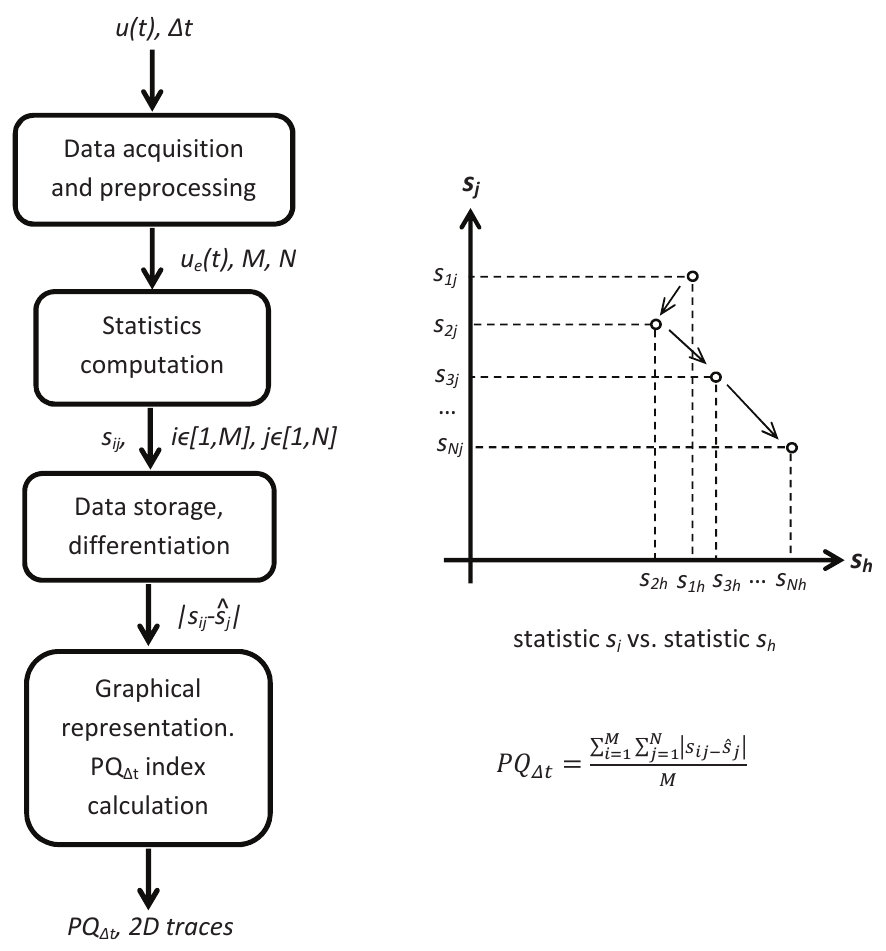
Figure 1. Measurement procedure along with the outputs: PQ index and 2D